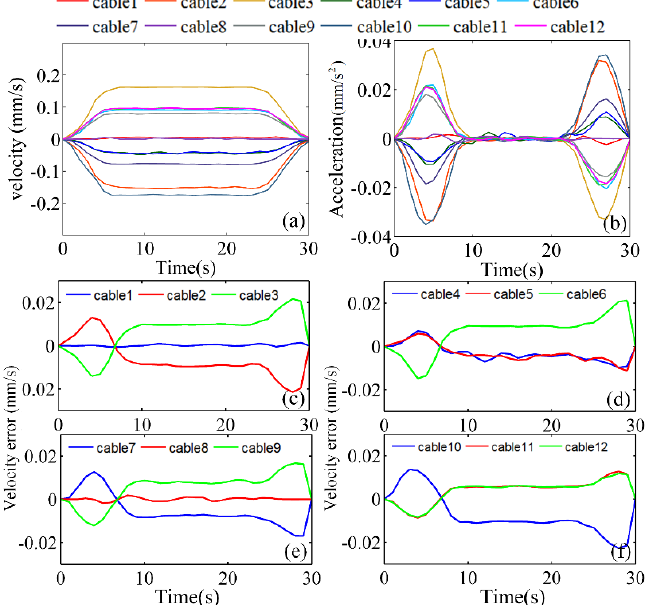
Figure 9. Velocity control of the 12 drive cables: ( a ) the actual velocity, ( b ) the actual acceleration, ( c – f ) the velocity errors of modules 1, 2, 3, and 4, respectively.